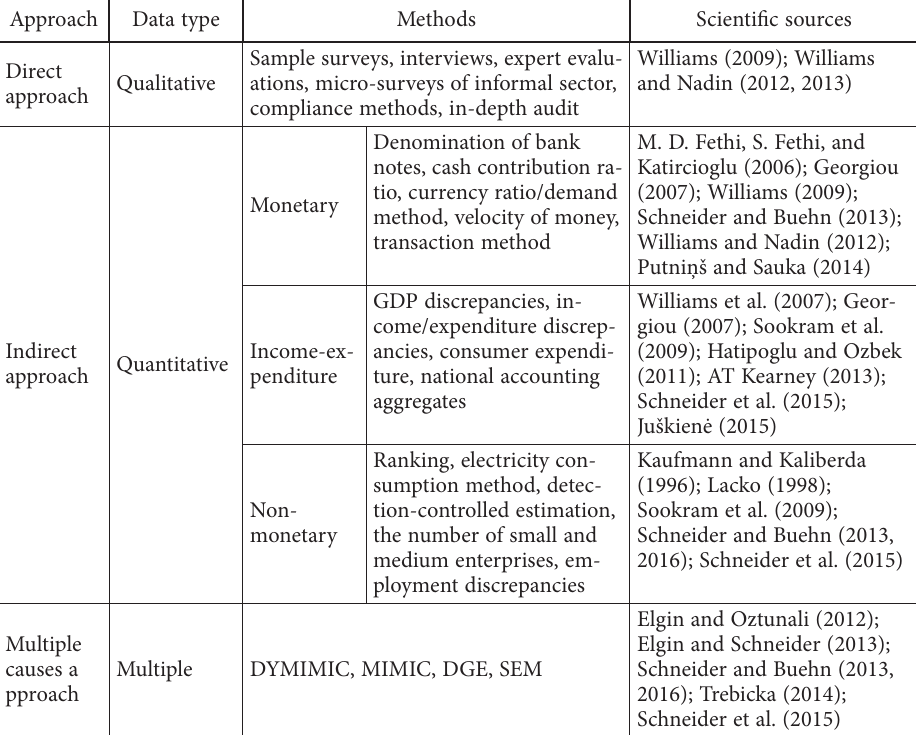
Table 1. The main shadow economy estimation methodologies (source: compiled by the